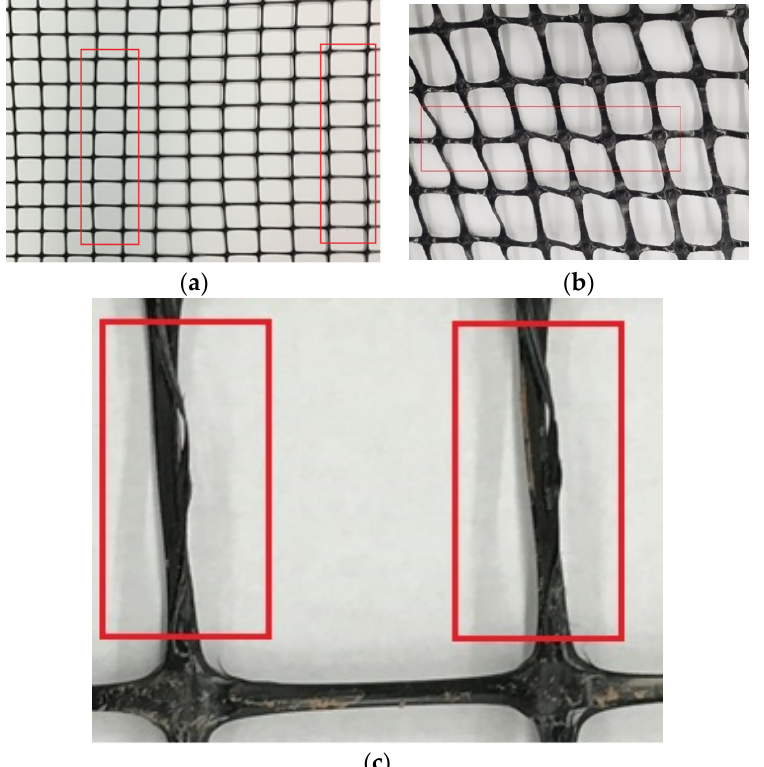
Figure 4. Manufacturing defects in geogrids: ( a ) Variability in aperture sizes, ( b ) bent ribs or variation in aperture shape, ( c ) splitting in geogrid